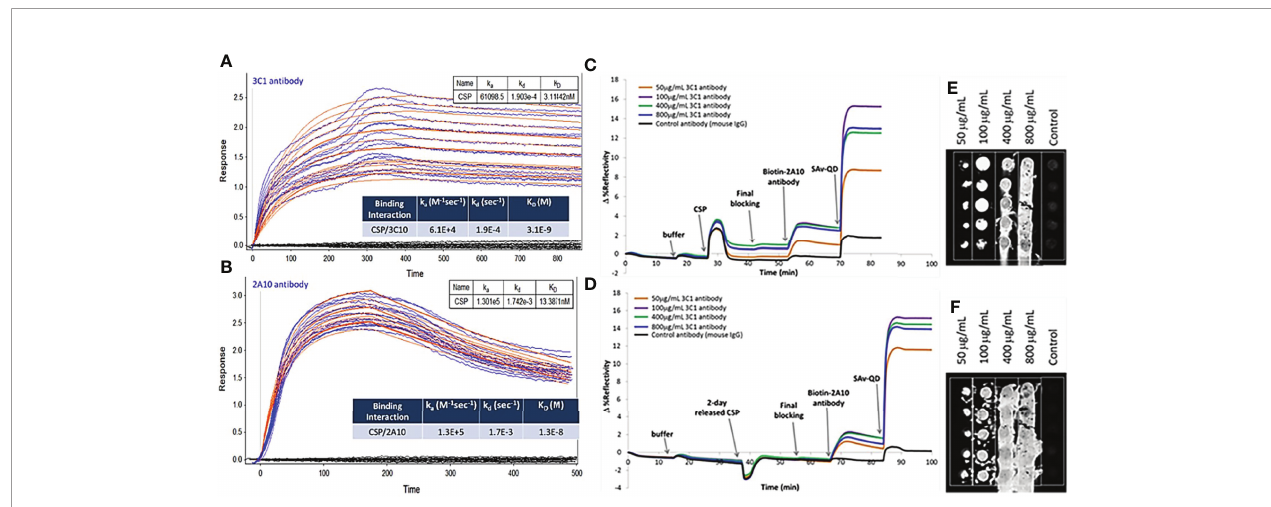
FIGURE 6 | Sensorgram fi ts and corresponding images of (A, B) CSP/3C1 and CSP/2A10 malaria antigen/antibody pairs using a 1:1 biomolecular interaction model to obtain kinetic parameters ka, kd and KD as shown in the insert Table. Anti-CSP antibody (3C1 or 2A10) was spotted as capture antibody (CAb) in 4 different concentrations. CSP protein (10 µg/mL) was then injected in the fl ow cell and allowed to interact with the immobilized CAb on the chip surface to determine association and dissociation of protein. (C, E) Sensorgrams for the detection of CSP and (D, F) 2-day released CSP from chitosan nanoparticles. Anti-CSP 3C1 as a capture antibody while anti-CSP 2A10 as detection antibody.